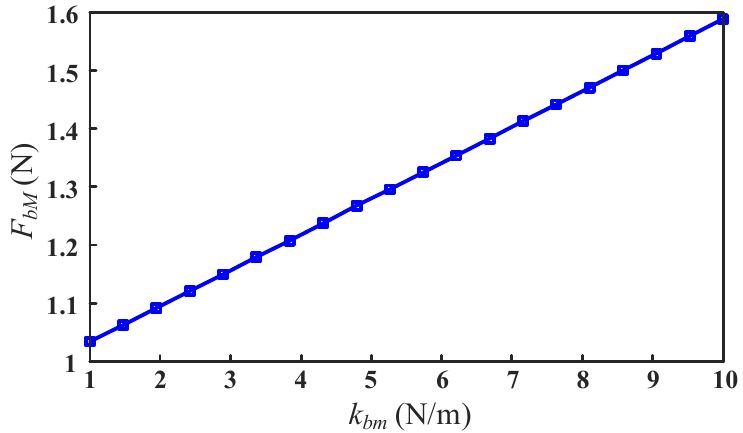
Figure 7. Influence of the bending stiffness of the flexure spherical hinge on the driving force of the mechanism.